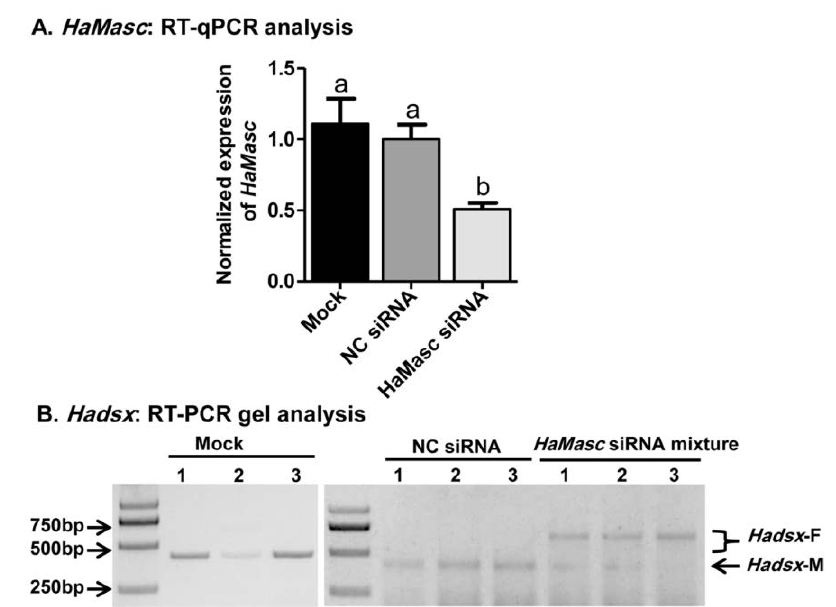
Figure 6. Effects of HaMasc siRNA mixture on the expression of HaMasc and Hadsx in the H. armigera male embryo cell line QB-Ha-E-1. ( A ) RT-qPCR analysis of HaMasc expression, and ( B ) RT-PCR analysis of sex-specific splicing of Hadsx . Mock was the female and male individual without treatment. Bars in ( A ) are means ± SE of normalized expression of HaMasc based on at least three biological replicates of three independent transfections of each siRNA. Bars with different letters (a, b in Figure 6A) are significantly different at p < 0.05 (one-way ANOVA followed by Tukey’s HSD